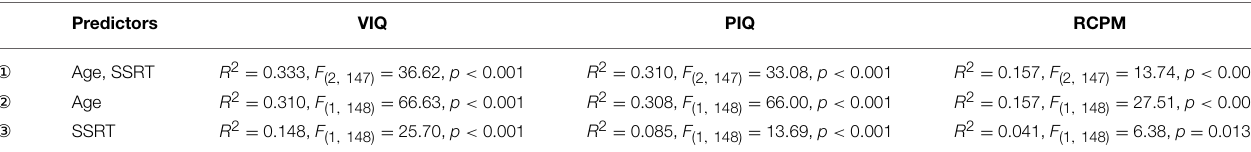
TABLE 4 | Regression analyses examining the contribution of age and SSRT to VIQ, PIQ, and RCPM. Predictors